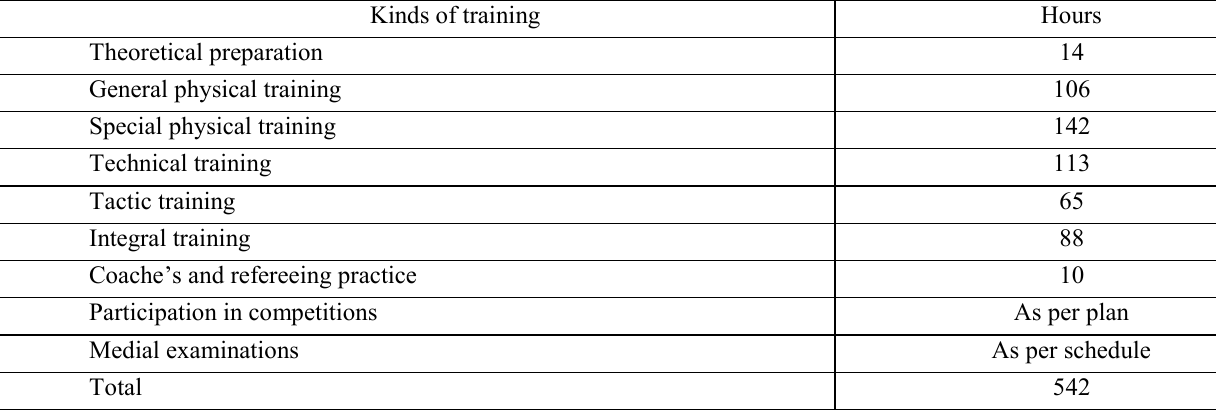
Distribution of training hours for kinds of training (CG and